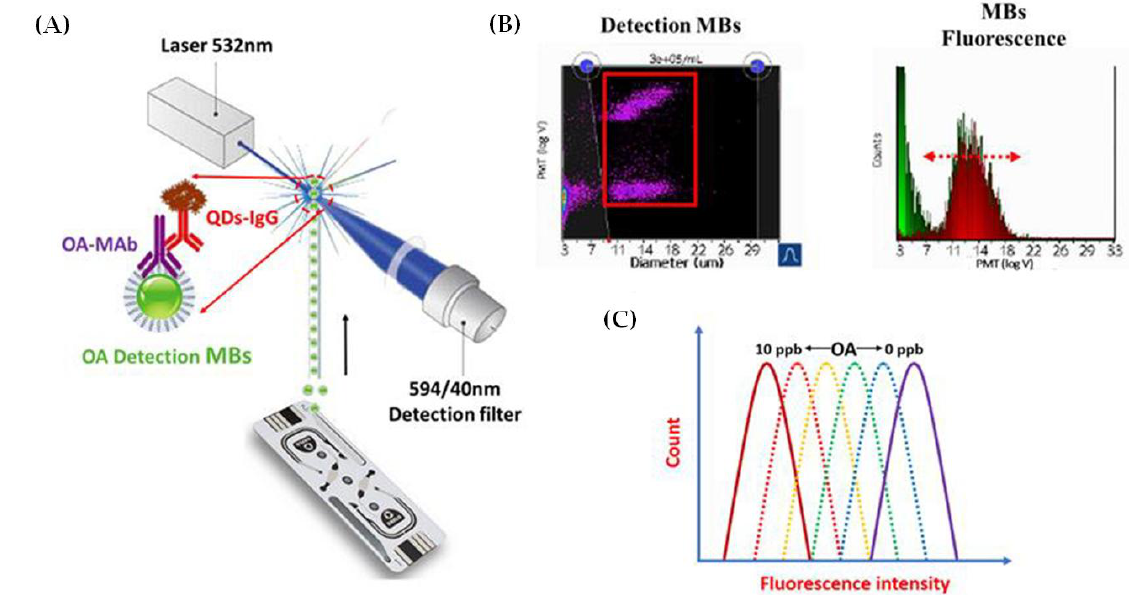
Figure 5. ( A ) working principle of fluorescence immunosensor for the detection of okadaic acid; ( B ) draw gate for the detection of magnetic beads and measure the fluorescence intensity; and ( C ) typical fluorescence intensity curves of fluorescent immunosensor under different okadaic acid concentrations. OA: okadaic acid; MBs: magnetic beads; MAb: monoclonal antibodies; QDs-IgG: quantum dots labelled with secondary antibodies IgG (© 2017, Pan et al. [63]. Originally published